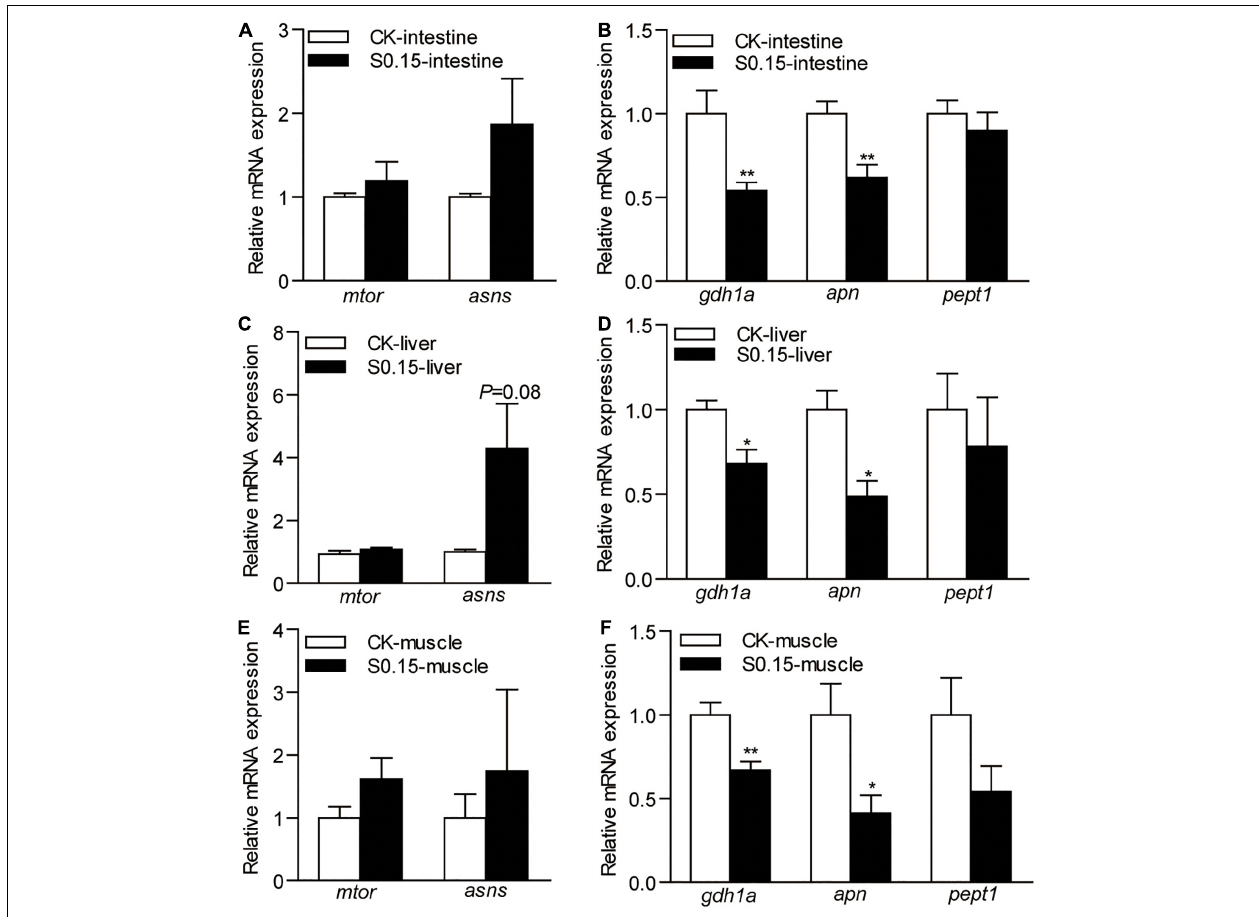
FIGURE 8 | The expression of protein metabolism-related genes in zebrafish fed the CK or S0.15 diet for 4 weeks. (A) Protein synthesis- and (B) protein degradation-related genes in the intestine. (C) Protein synthesis- and (D) protein degradation-related genes in the liver. (E) Protein synthesis- and (F) protein degradation-related genes in the muscle. Values are means ± SEMs ( n = 6 biological replicates). * p < 0.05, ** p < 0.01. CK, control-check diet; S0.15, 0.15% succinate-supplemented